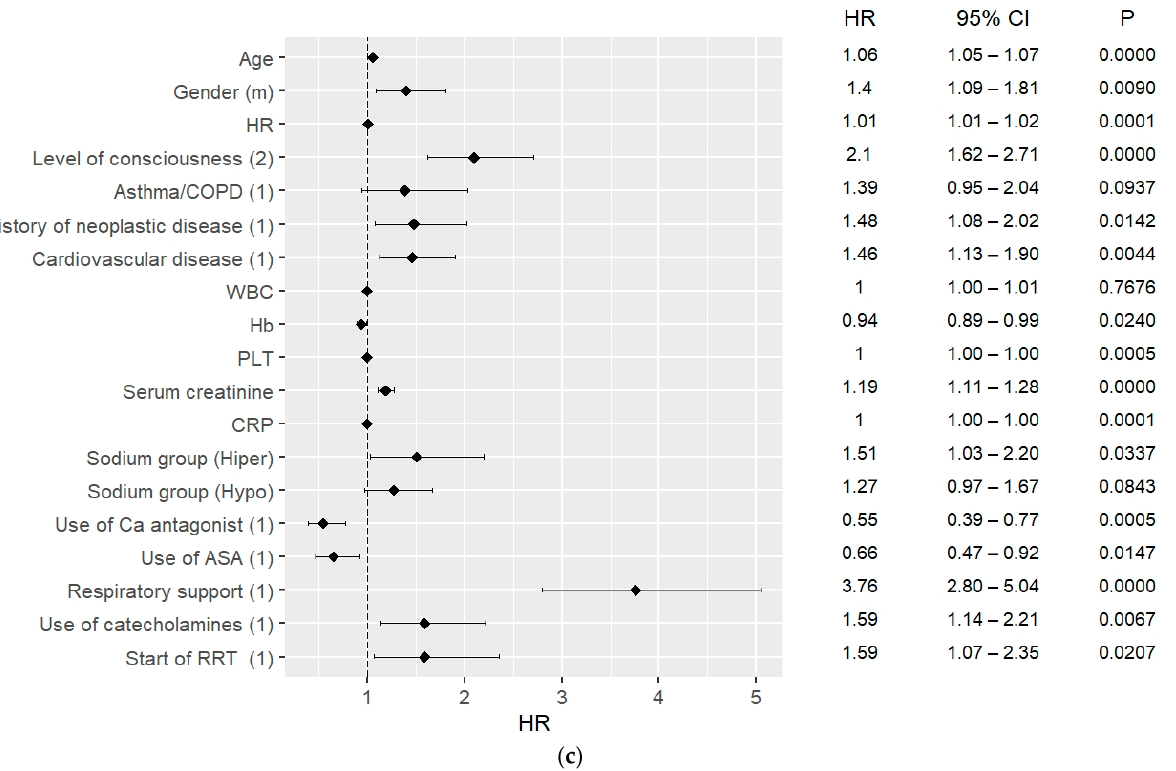
Figure 2. ( a ) 30-day mortality predictors in COVID patients, data on admission; ( b ) 30-day mortality predictors in COVID patients, including ICU patients; ( c ) 30-day mortality predictors in COVID patients, excluding ICU patients.